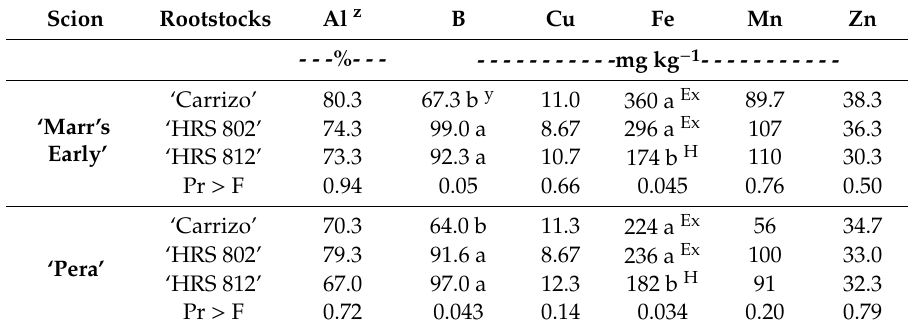
Table 3. Mean concentrations of plant micronutrients and trace elements in 2016 of two sweet orange cultivars growing on Alonso clay series soil grafted on three di ff erent rootstocks at the Agricultural Experiment Station of Adjuntas, Puerto Rico.